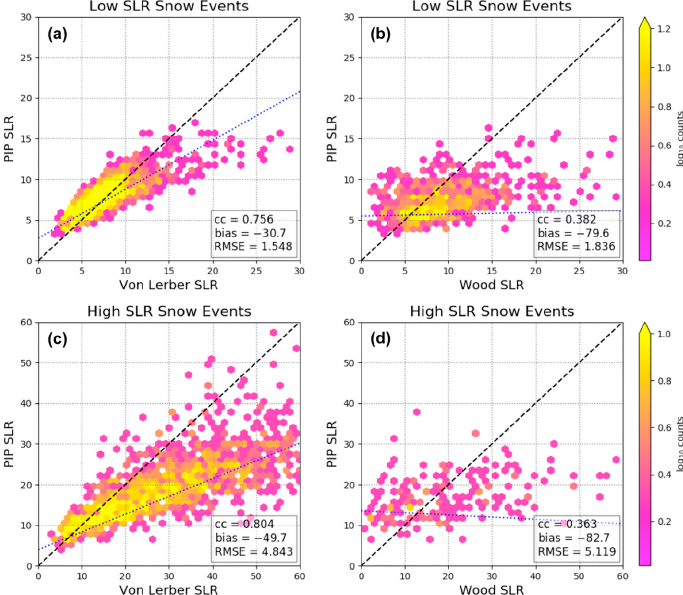
Figure 8. Shown are comparisons of the respective ρ e inverted into SLR. The PIP-derived SLRs are plotted along the y-axes in each panel, whereas the von Lerber and Wood-retrieved SLRs are plotted along the x-axes (( a ), ( c ) and ( b ), ( d ), respectively). ( a ) and ( b ) illustrate the results from the low SLR snow events and ( c ) and ( d ) illustrate the results from the high SLR snow events. The black dashed line represents a 1:1 relationship, while the blue dotted line is the linear regression fit to the data.